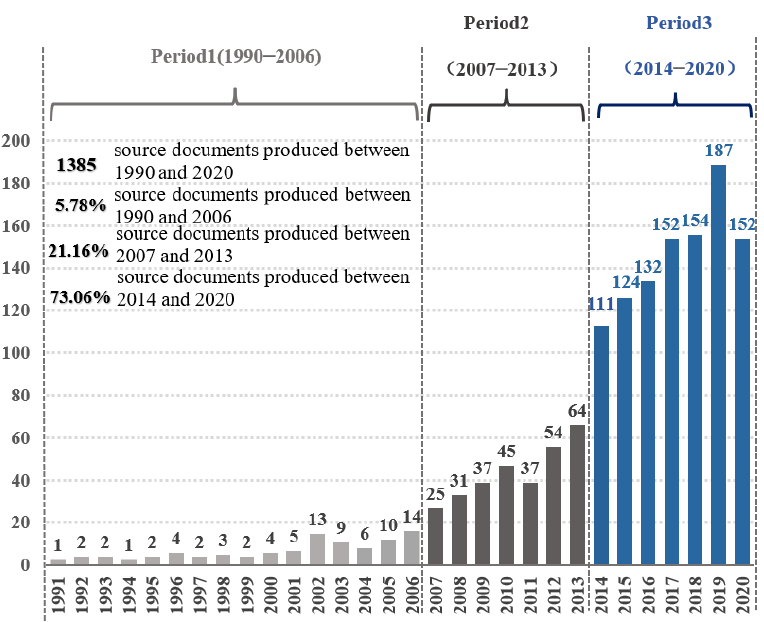
Figure 3. publication growth trend around the world. Figure 3. Publication growth trend around the